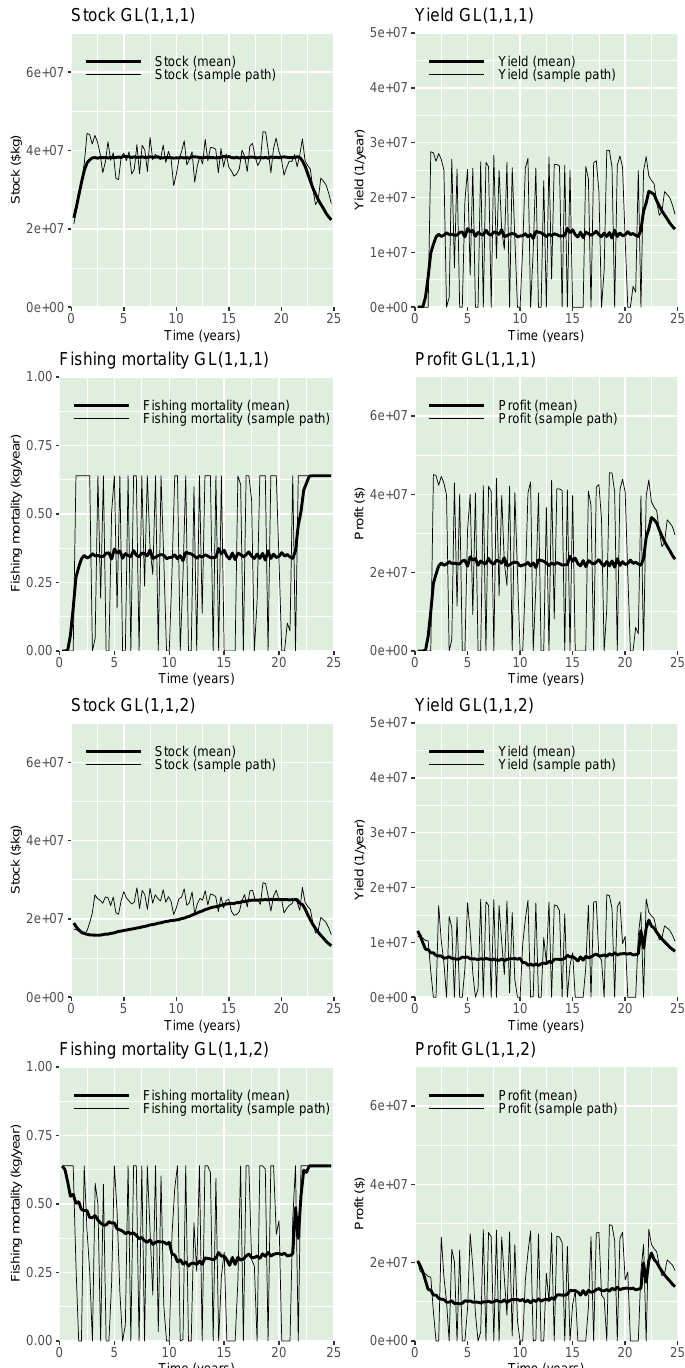
Figure 2. Stock, fishing mortality, yield, and profit sample paths (thinner line) and mean (ticker line) obtained by the application of models GL ( 1,1,1 ) ( top panel) and GL ( 1,1,2 ) ( bottom panel). Unit values are described in Table